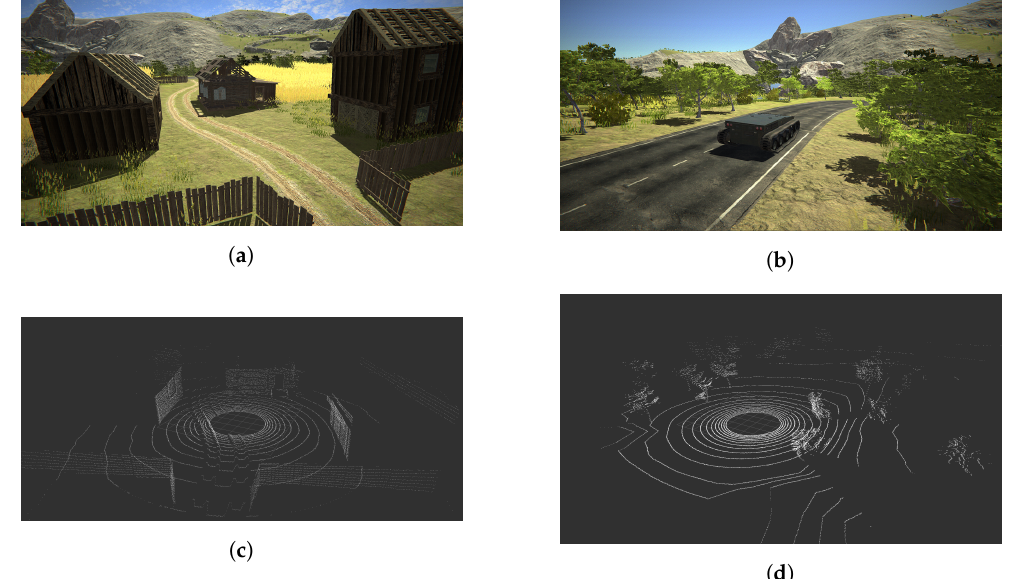
Figure 8. Sample LiDAR Point Cloud extracted from two simulated heterogeneous environments. ( a ) A screenshot of a simulated rural environment; ( b ) A screenshot of a simulated natural environ- ment; ( c ) Extracted point cloud from a simulated environment ( a ); ( d ) Extracted point cloud from a simulated environment ( b